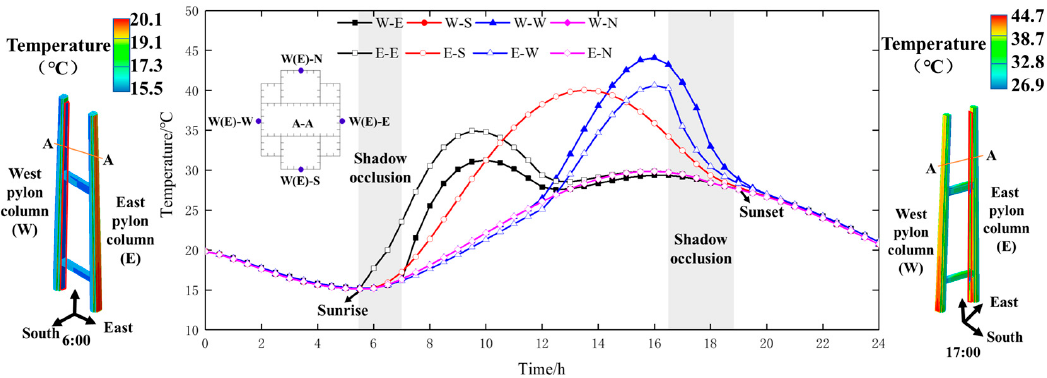
Figure 12. Temperature Variation curve of cross-section A-A on bridge pylon in spring (autumn).